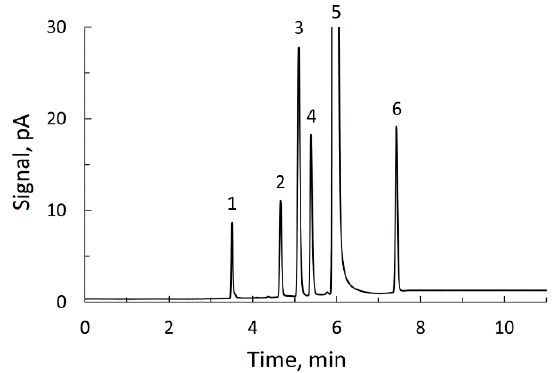
Figure 5. Gas chromatogram of a standard for determination of volatile compounds in ciders: 1, acetaldehyde; 2, acrolein; 3, ethyl acetate; 4, methanol; 5, ethanol; 6, acetonitrile (internal standard). Table 1. Acrolein concentration in eight commercial ciders. Determined by 1 H NMR and GC methods. * Concentration, mg / Cider